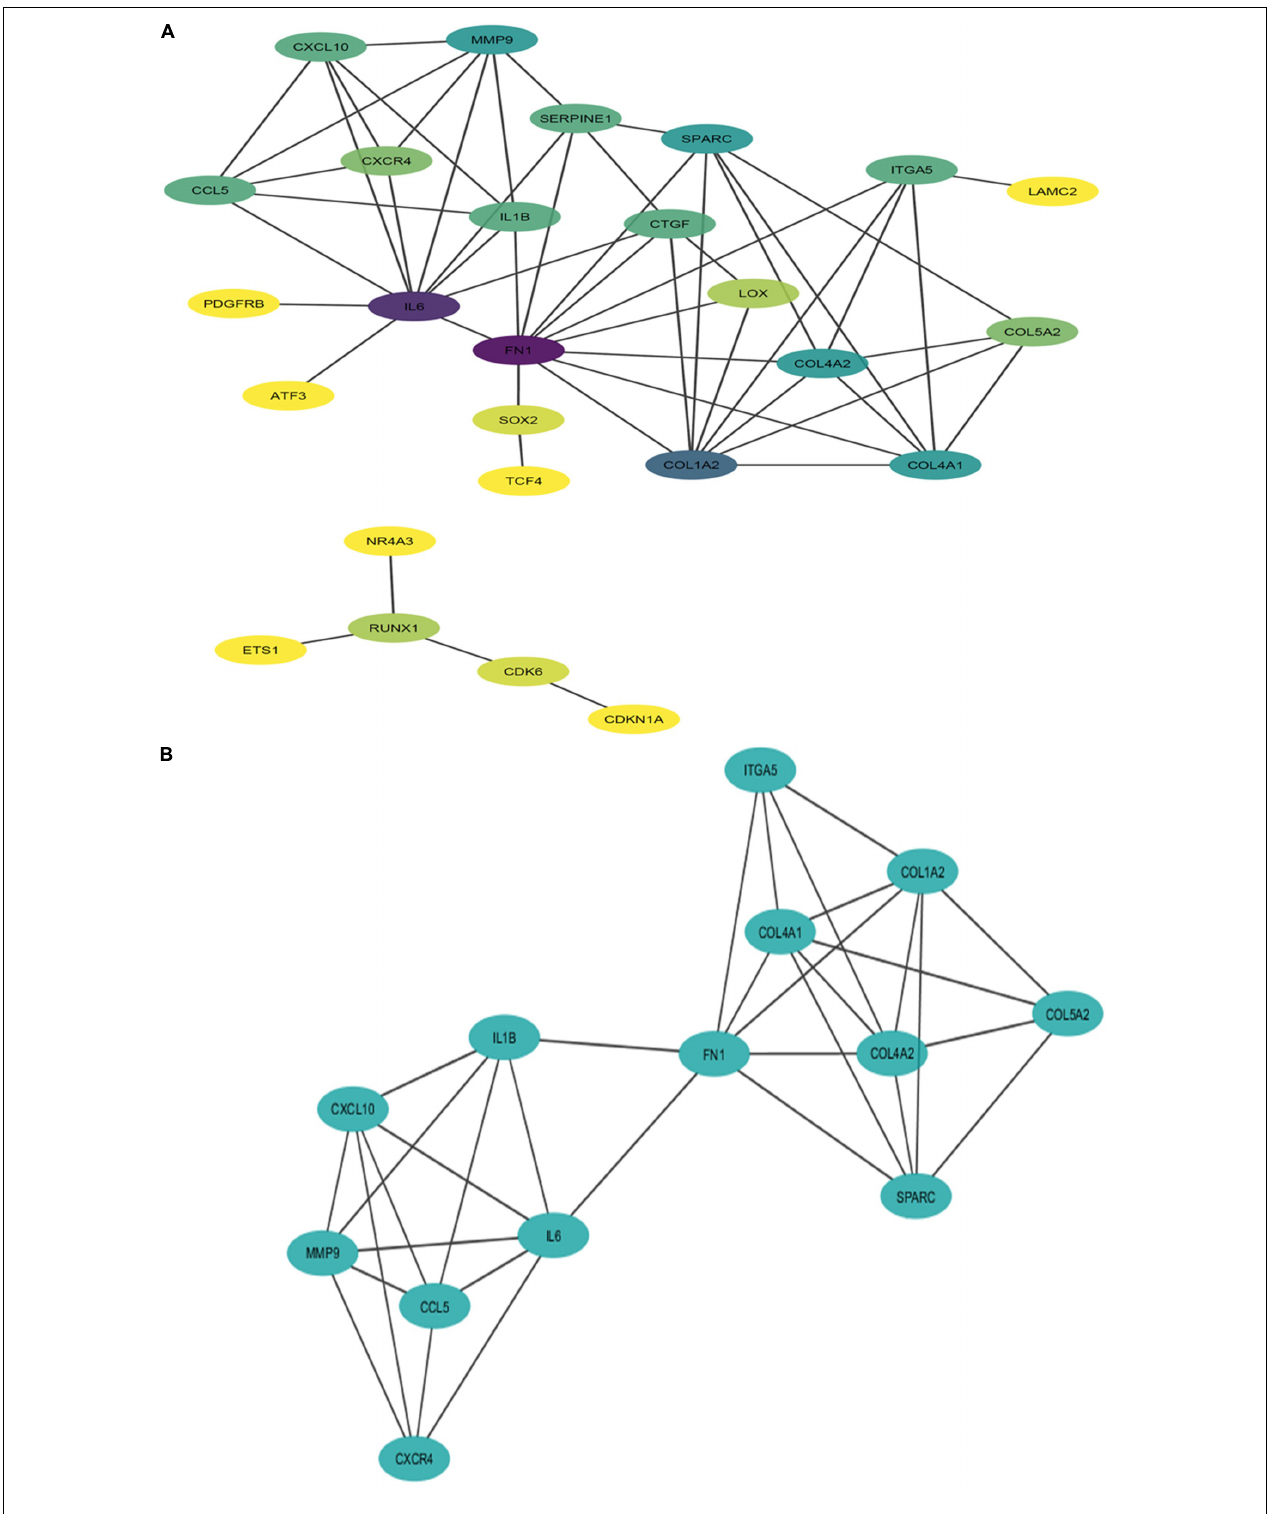
FIGURE 6 | Interaction network and module of potential DR candidate genes. (A) Protein-protein interaction (PPI) network of potential DR candidate genes: the intensity of node color denotes the degree of interactions it has with other nodes (dark purple color denotes the highest number of interactions followed by blue, light blue, green, light green, etc., and yellow denotes the lowest number of interaction). (B) Module (MCODE score 5.67 and number of nodes 13) obtained from PPI network of potential DR candidate genes.